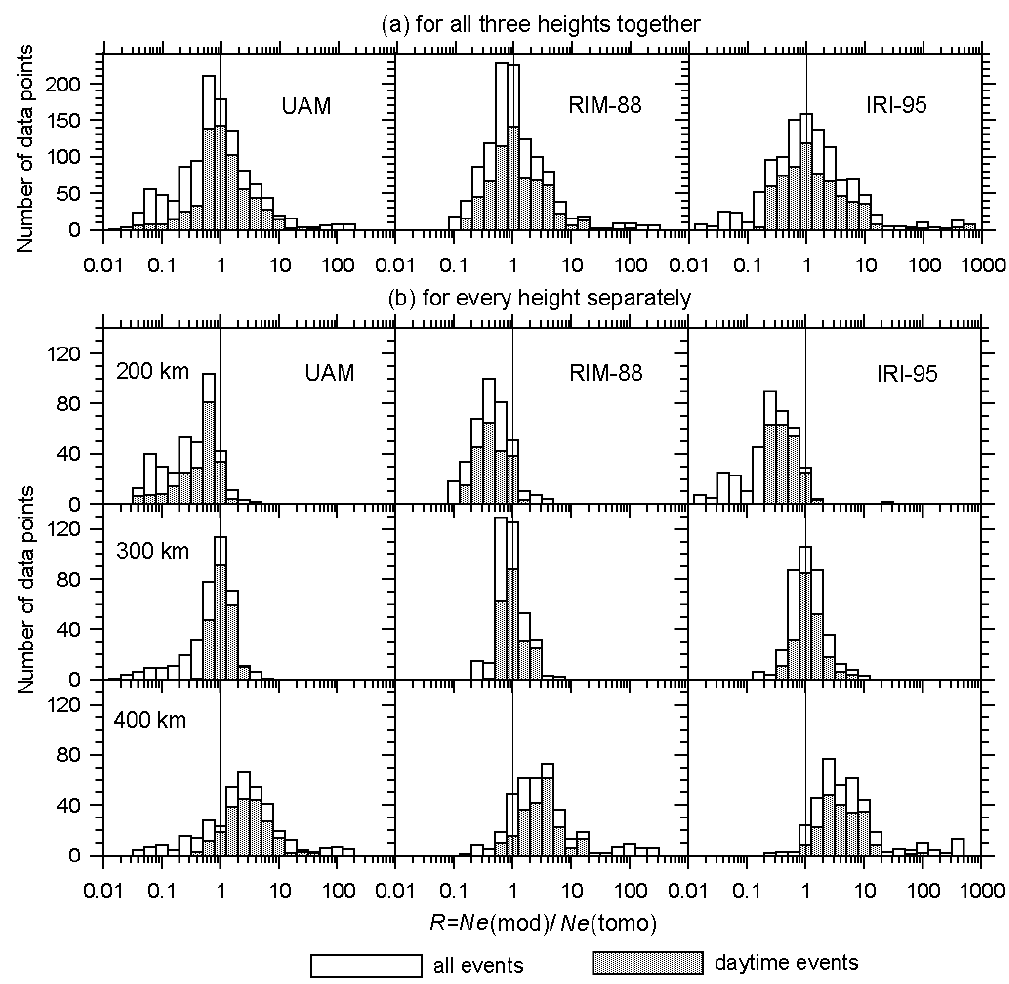
Fig. 11. Histograms of the ratios of the model electron density to the electron density measured by the radio tomography, R = N e (mod)/ N e (tomo), for three ionosphere models: the theoretical model UAM (left column) and two empirical models RIM-88 (middle column) and IRI-95 (right column). (a) For all three heights together (200, 300 and 400km). (b) For every height